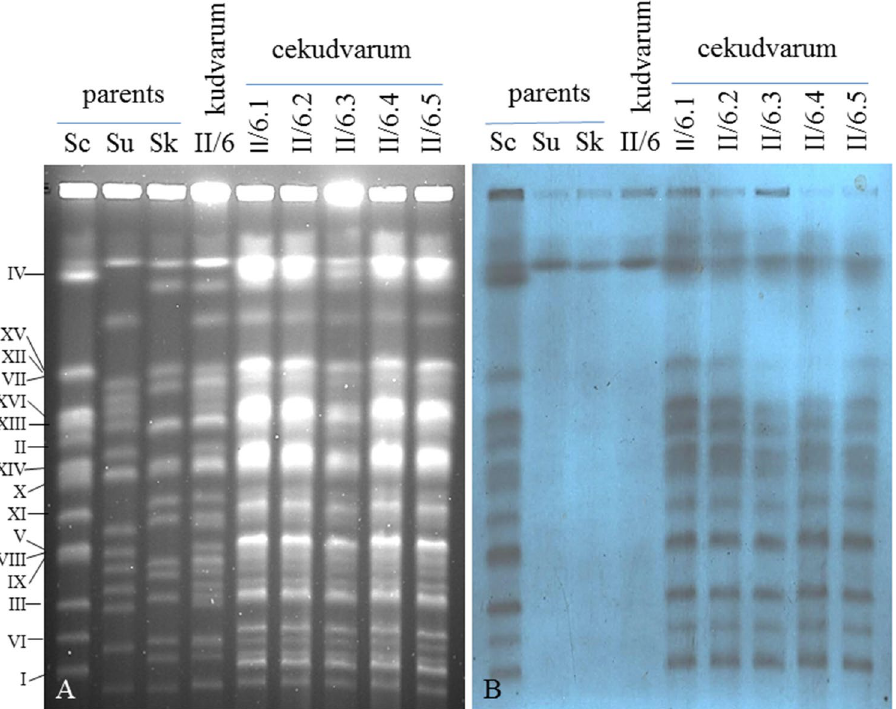
Figure 2. Karyotyping. ( A ) Separation of chromosomes. ( B ) Southern hybridisation with S. cerevisiae Y’ telomeric sequence. Sc: 10–170 S. cerevisiae . Su: 10–1651 S. uvarum . Sk: 1653 S. kudriavzevii . Designation/ numbering of S. cerevisiae chromosomes is shown on the left